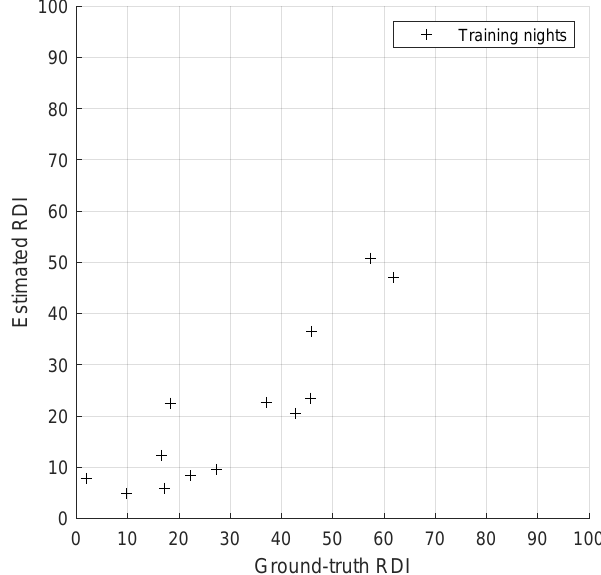
Figure 7. Results on the learning dataset, i.e., correlation of 0.88; x -axis: reference RDI; y -axis: estimator’s output.